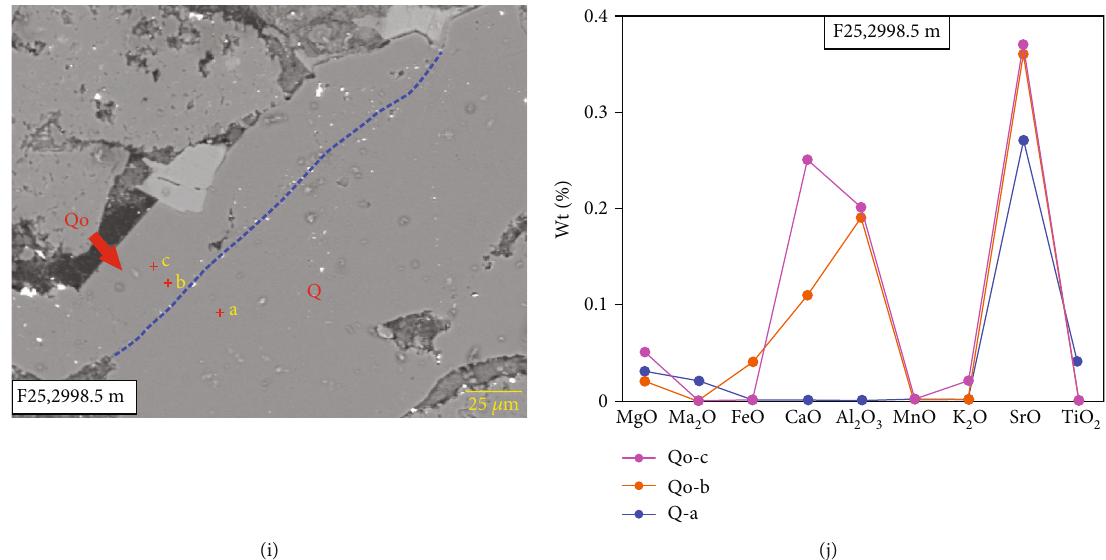
Figure 13: EPMA analysis of detrital quartz and quartz overgrowth (Qo) in the Es3x interval. (a, c, e, g, i) BSE images showing the EPMA analysis position. (b, d, f, h, j) Elemental composition characteristics in detrital quartz and Qo.